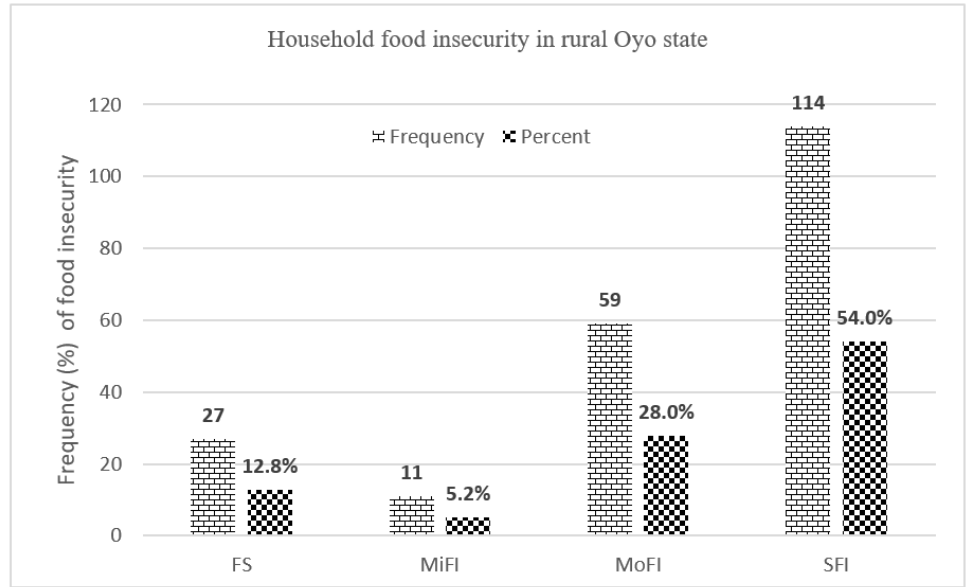
Figure 2. Food insecurity status among rural farming households in Oyo State, Nigeria. Source: authors’ graph using farming households’ food insecurity categories. FS = food secure; MiFI = mildly food insecure; MoFI = moderately food insecure; SFI = severely food insecure.